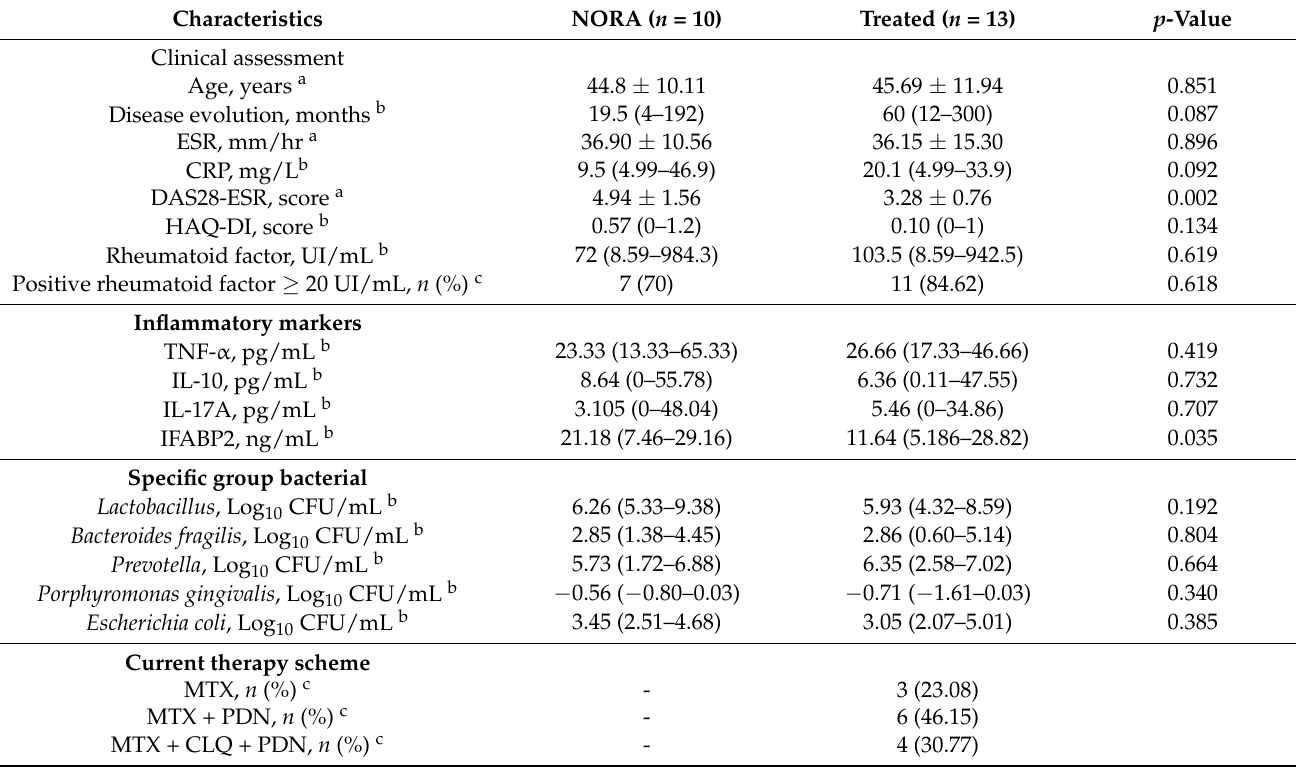
Table 1. Clinical, inflammatory markers and intestinal bacteria abundance in the group RA